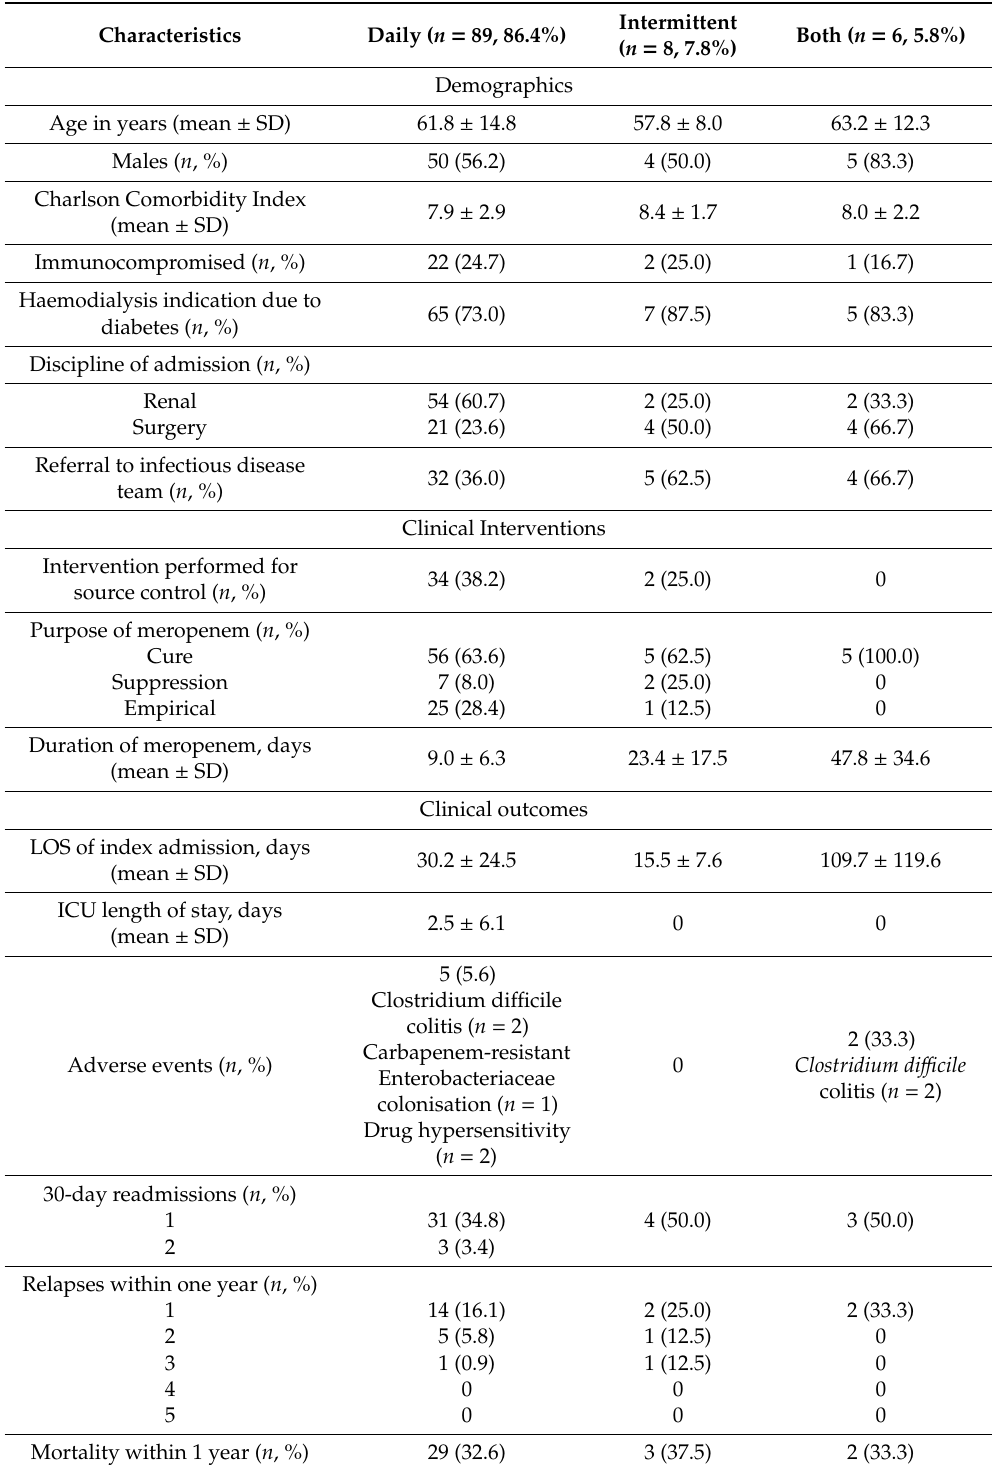
Table 1. Comparison of di ff erent meropenem dosing